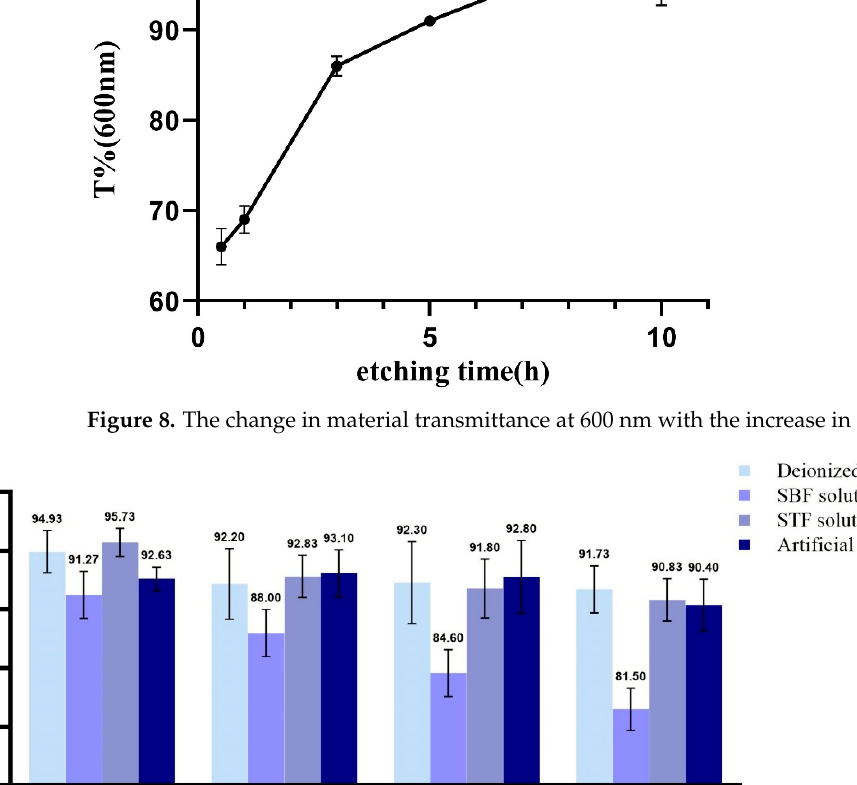
Figure 9. The change in transmittance of fish scale collagen lamellar matrix soaking in different solutions for 4 weeks ( n = 3).